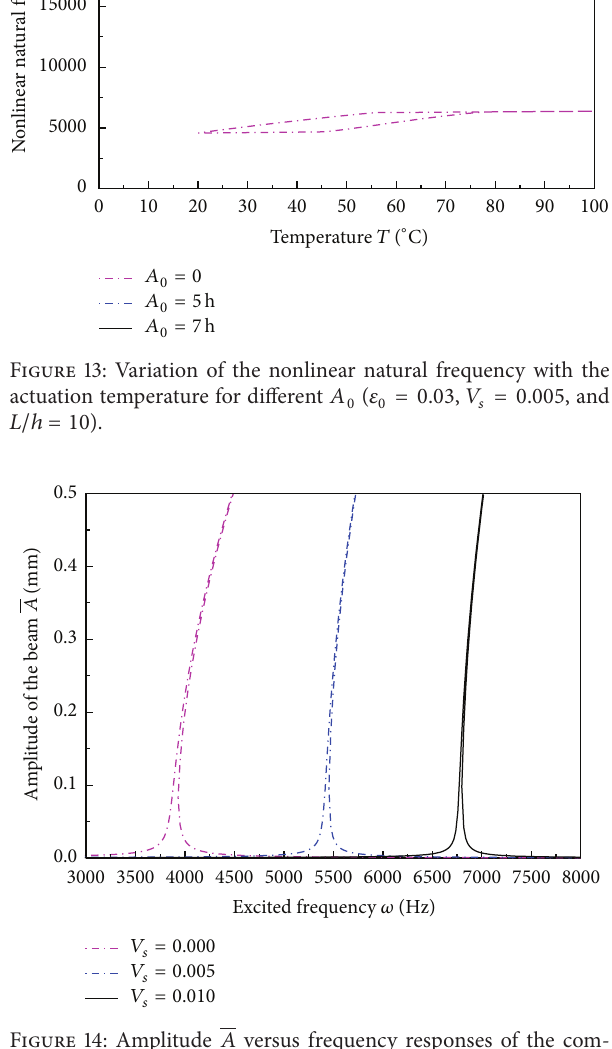
Figure 12: Variation of the nonlinear natural frequency with the actuation temperature for different 𝜀 0 ( 𝑉 𝑠 = 0.005 , 𝐴 0 /ℎ = 1 , and 𝐿/ℎ = 10 ).